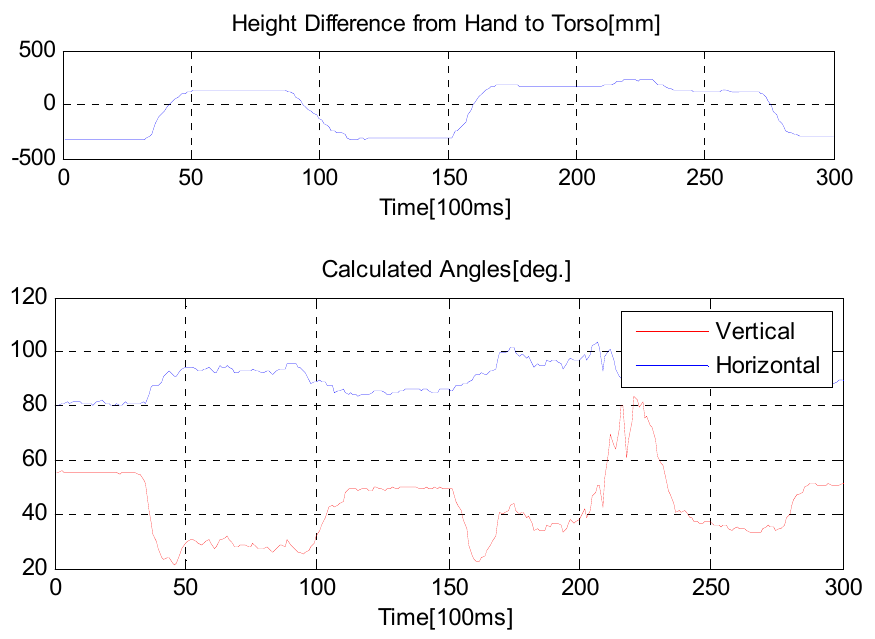
Figure 11. Calculated